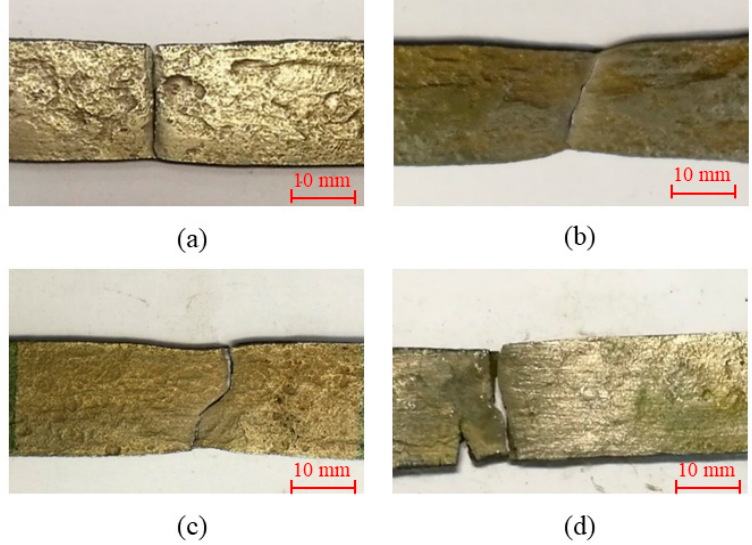
Figure 8. Fracture mode: ( a ) flat fracture; ( b ) oblique fracture; ( c ) step fracture; ( d ) multiple fracture.